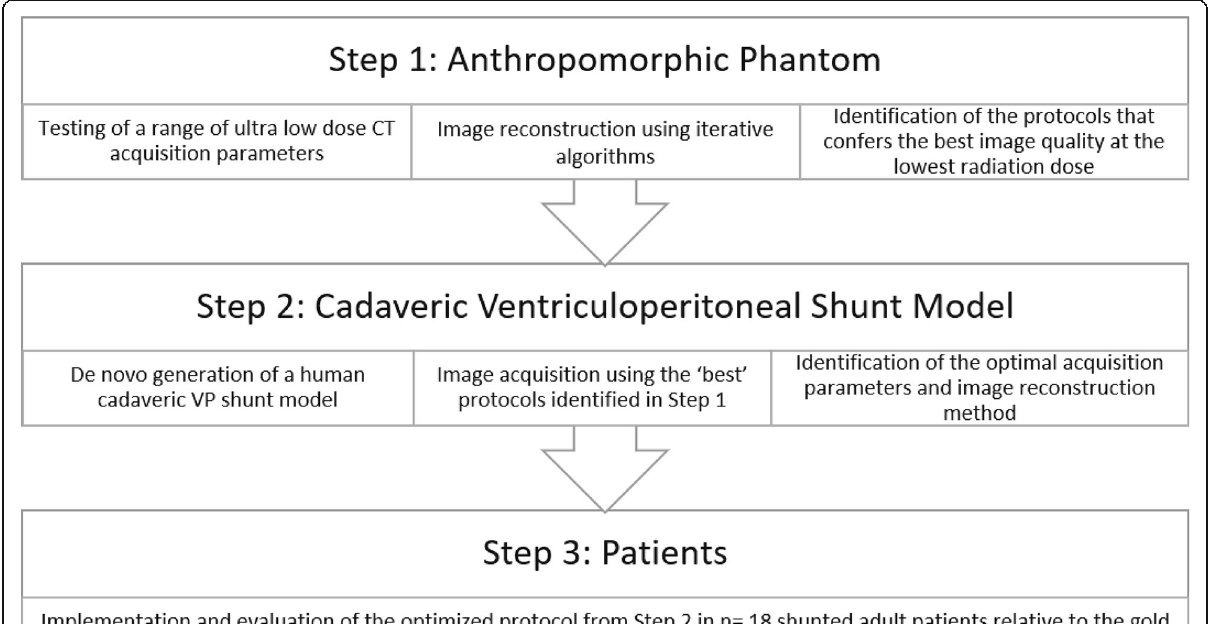
Fig. 1 Study flow diagram. VP